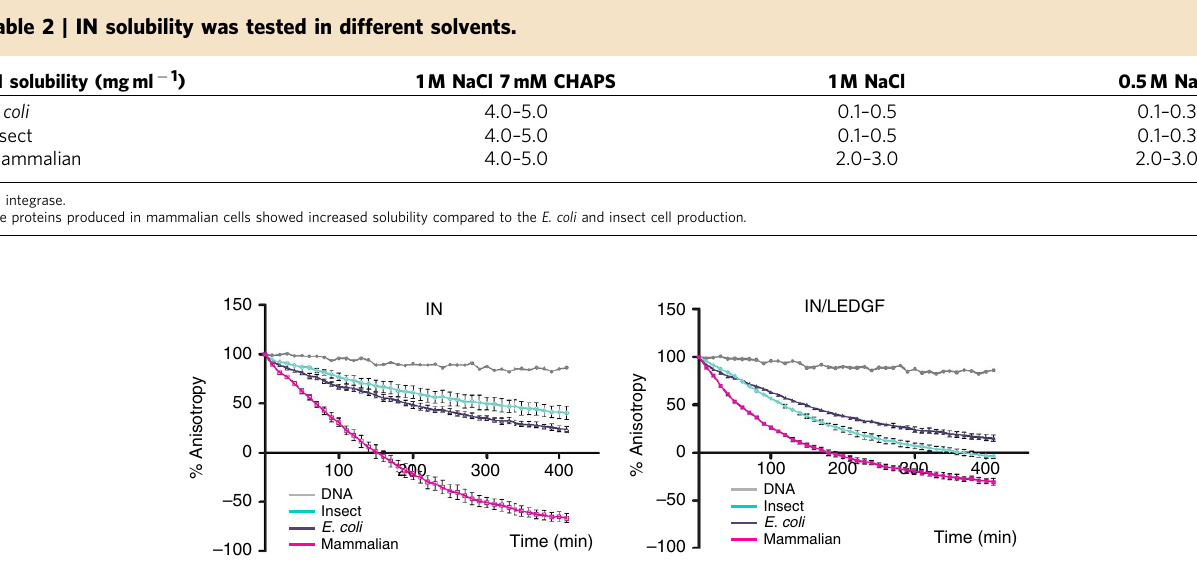
Figure 6 | Functional 3 0 -processing assay. The IN and the IN/LEDGF produced in mammalian cells have a higher enzymatic activity compared to those purified from insect or E. coli